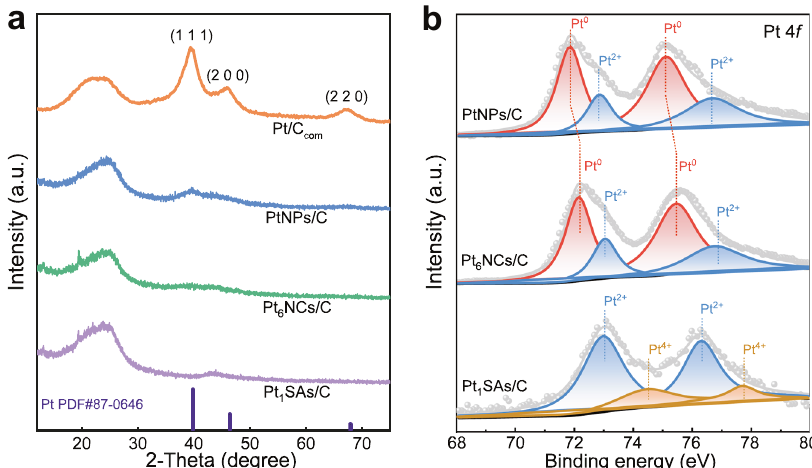
Fig. 2 Structural characterizations of carbon-supported Pt-based catalysts. a XRD patterns of Pt 1 SAs/C, Pt 6 NCs/C, PtNPs/C, and Pt/C com . b Pt 4 f XPS spectra comparison of Pt 1 SAs/C, Pt 6 NCs/C, and